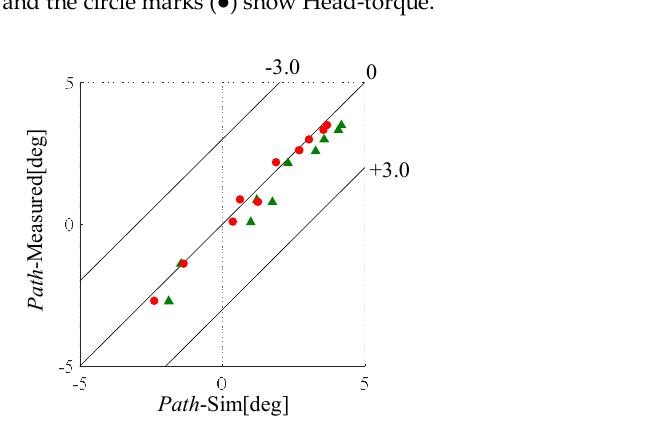
Figure 12. Comparison of measured and simulated results of Path. The triangle marks ( ▲ ) show the result without Head-torque, and the circle marks (●) show